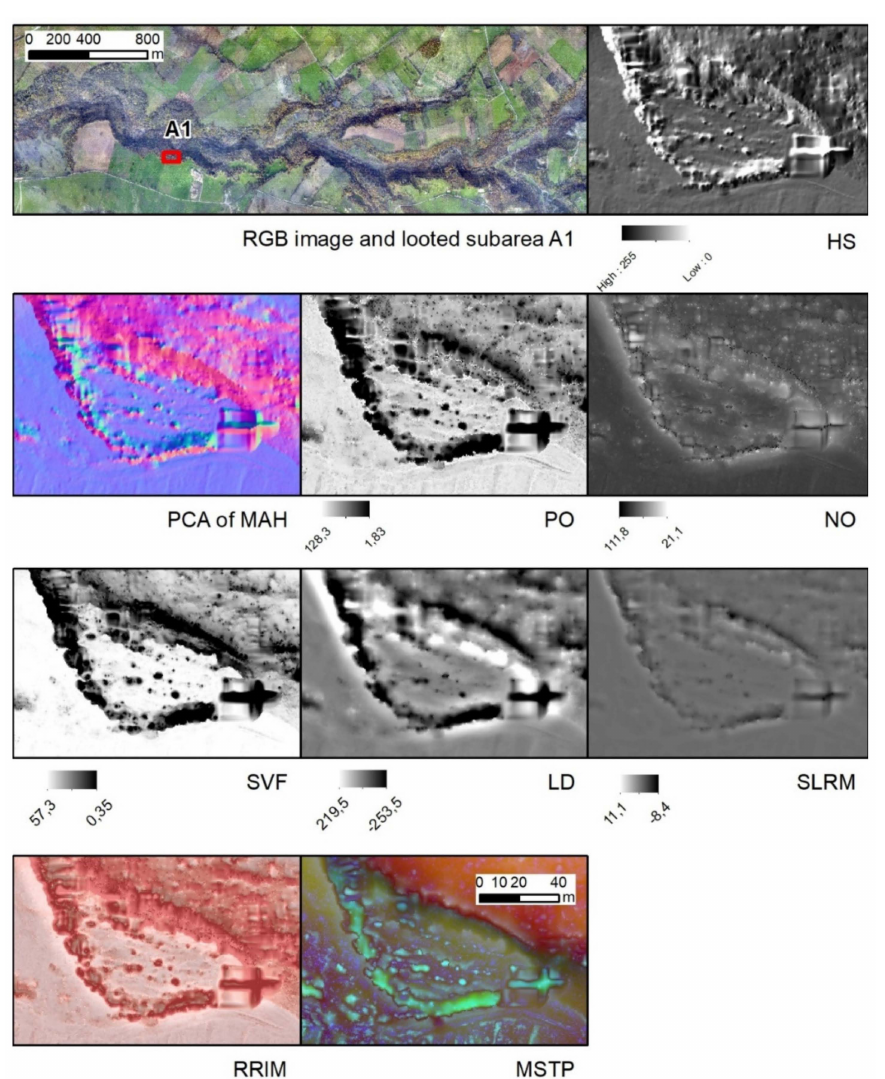
Figure 4. The first of the four areas found with VTs affected by looting (A1). In the left-high corner, the localization of the A1 subarea is overlaid to the RGB image. In the other frames the different VT results are